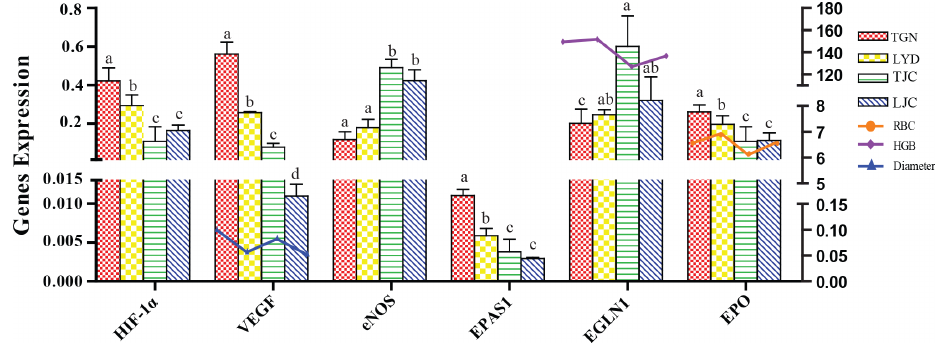
Figure 4. Expression levels of HIF - 1 α , EPAS1 , EPO , VEGF , eNOS and EGLN1 in the lungs of the four types of pigs and the relationship between VEGF , EPO and EGLN1 and diameter, RBCs and HGB. Note: the different letters above the bars indicate that the expression levels differed significantly ( P< 0 . 05, mean ± SE), and the same letters indicate that the levels did not differ significantly ( P> 0 . 05, mean ± SE) in different